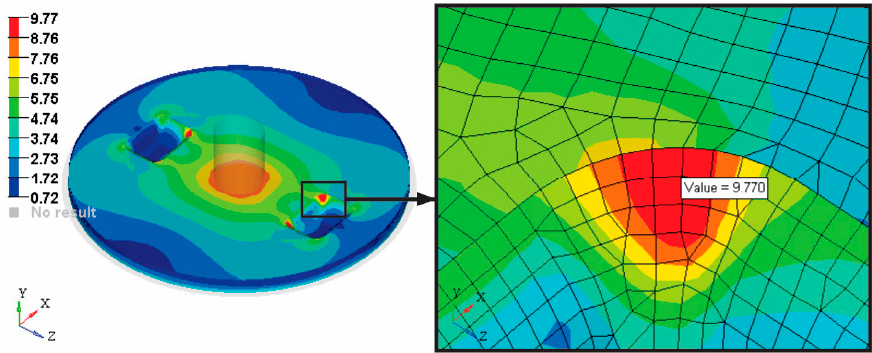
a. b. Figure 18. Plot strain on the upper face of layer 5: ( a ) Strains ε x with respect to Ox axis; ( b ) strains ε z with respect to Oz axis.